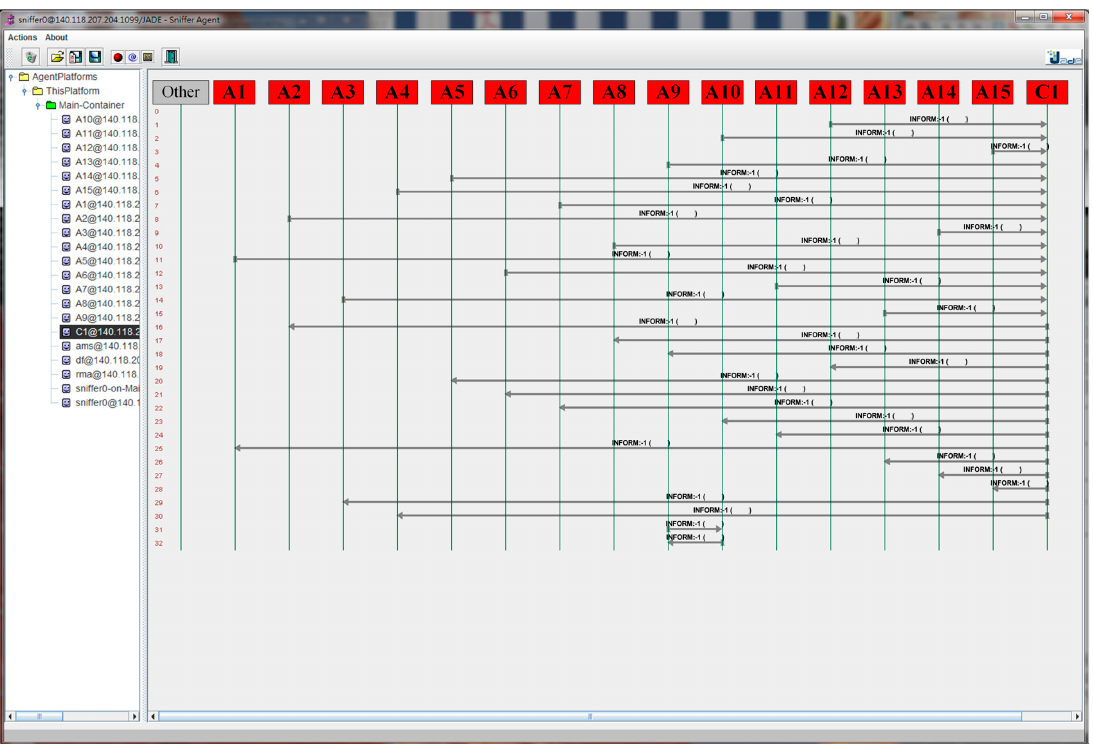
Figure 9. Interactive communication of the agents under grid-connected mode and fault occurrence at Bus 1.